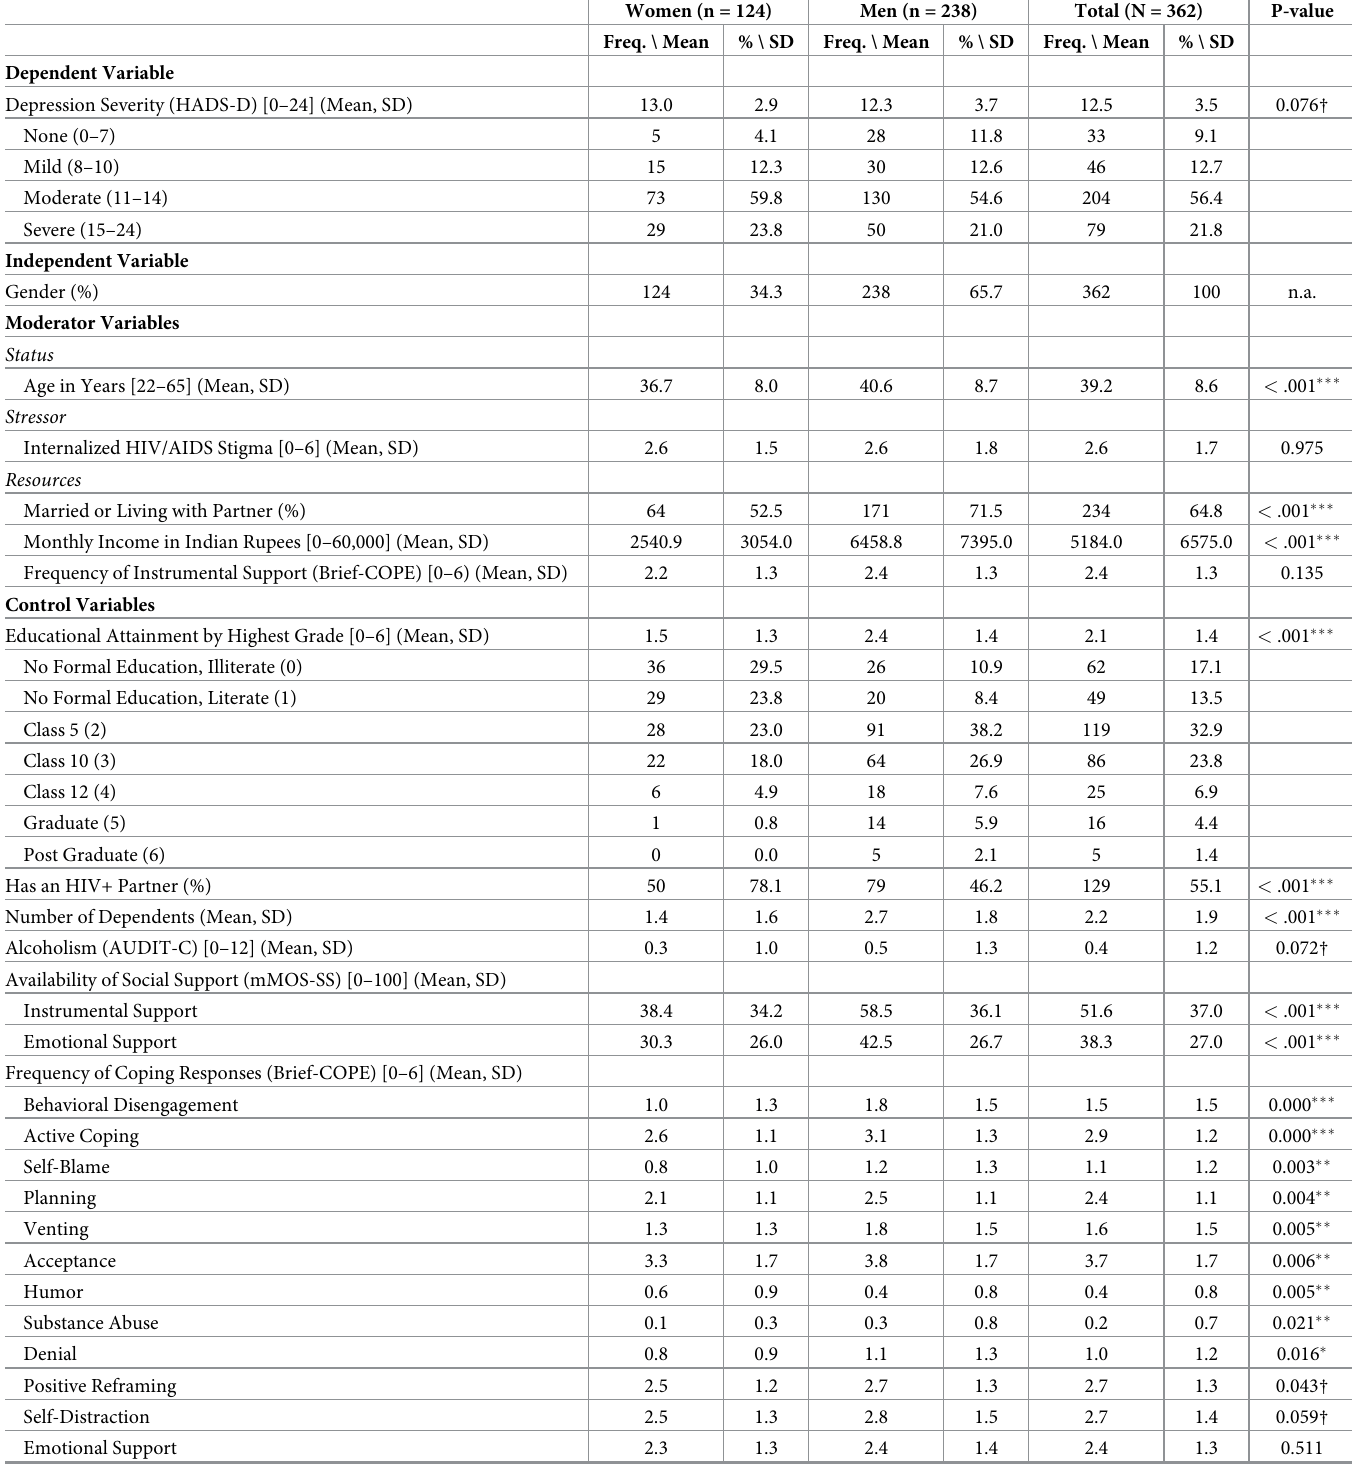
Table 1. Sample characteristics of people living with HIV in India, stratified by gender (N =